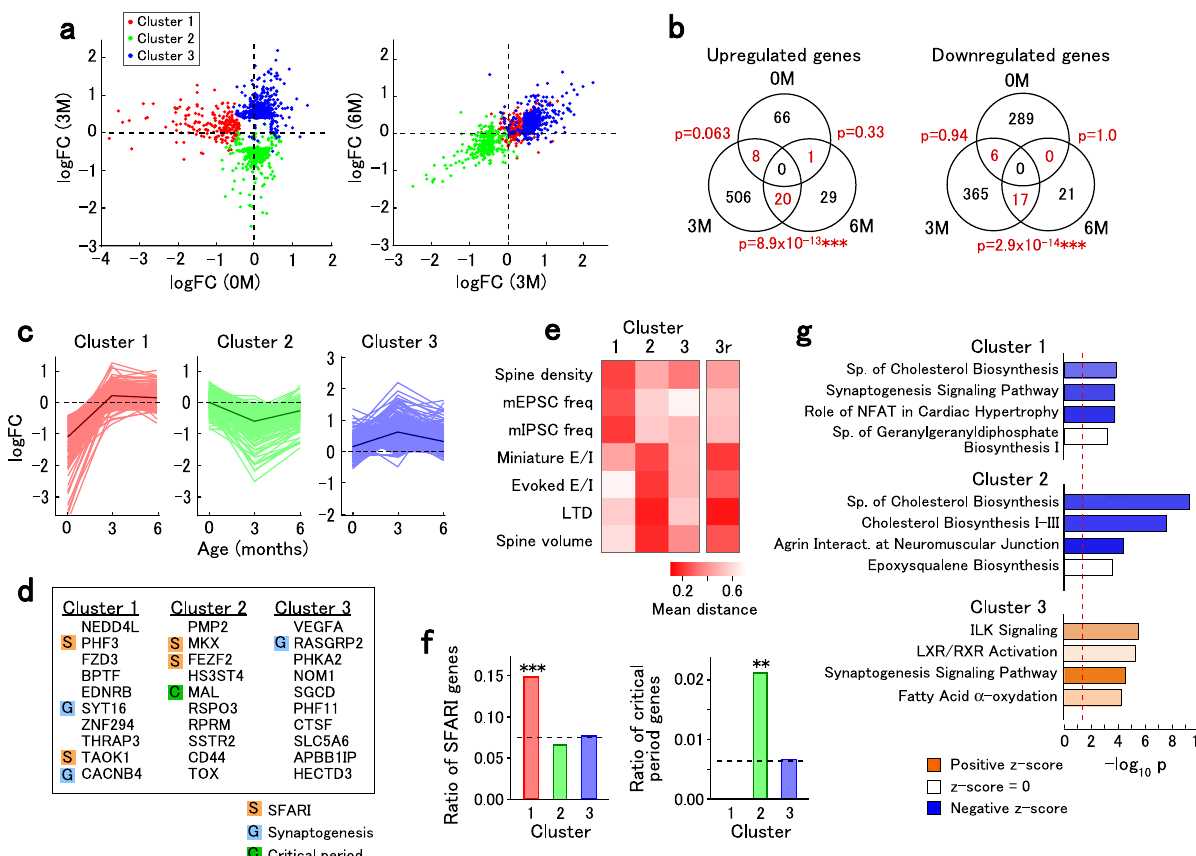
Fig. 4 Microarray analysis of differential gene expression. a Distribution of the logFC values of gene expression signi fi cantly modulated by VPA exposure. The logFC values at 3 M are plotted against those at 0 M (left) while the logFC values at 6 M are plotted against those at 3 M (right). Each gene is colored based on the cluster. The microarray data are from 10 samples from 5 animals (0 M UE), 11 samples from 4 animals (0 M VPA), 9 samples from 6 animals (3 M UE), 6 samples from 2 animals (3 M VPA), 9 samples from 6 animals (6 M UE), and 6 samples from 2 animals (6 M VPA). b Common upregulated and downregulated genes across ages. P values are for the enrichment of common genes between ages (one-sided Fisher ’ s exact test). c The time course of logFC values. The traces in light colors represent data from individual genes in the cluster. The traces in dark colors represent the average of all genes in the cluster. d List of genes with the highest expression modulations in each cluster. SFARI, synaptogenesis-related, and critical period-related genes are marked. e The distance between the average logFC values of gene expression for each cluster and the logFC values of structural and physiological parameters (spine density, mEPSC frequency, mIPSC frequency, E/I ratio of miniature synaptic currents, E/I ratio of evoked synaptic currents, post-LTD fi eld EPSP amplitudes, and spine volume). The column labeled “ 3r ” shows the distance between the negative of the average logFC values of cluster 3 and the structural and physiological parameters to highlight parameters that are inversely correlated with cluster 3. f Enrichment of SFARI and critical period- related genes in each cluster. The dotted line is the ratio among the entire gene set. One-sided Fisher ’ s exact test for SFARI gene enrichment, p = 0.00088 (0 M), p = 0.90 (3 M), p = 0.68 (6 M); for critical period gene enrichment, p = 1.0 (0 M), p = 0.0028 (3 M), p = 0.57 (6 M). *** p < 0.001, ** p < 0.01. g Enriched pathways for each cluster. The color of the bars represents the direction of regulation of the pathway based on the logFC values at 0 M (cluster 1) and 3 M (clusters 2 and 3). Sp, superpathway. The p-values of enrichment were provided by the IPA software. The red dotted line represents the threshold of signi fi cance ( p =